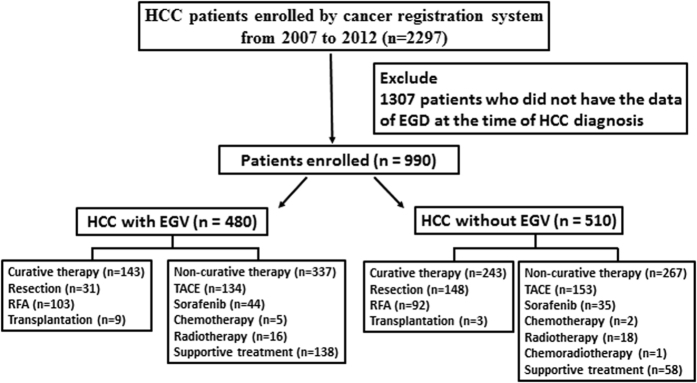
The study flow chart.